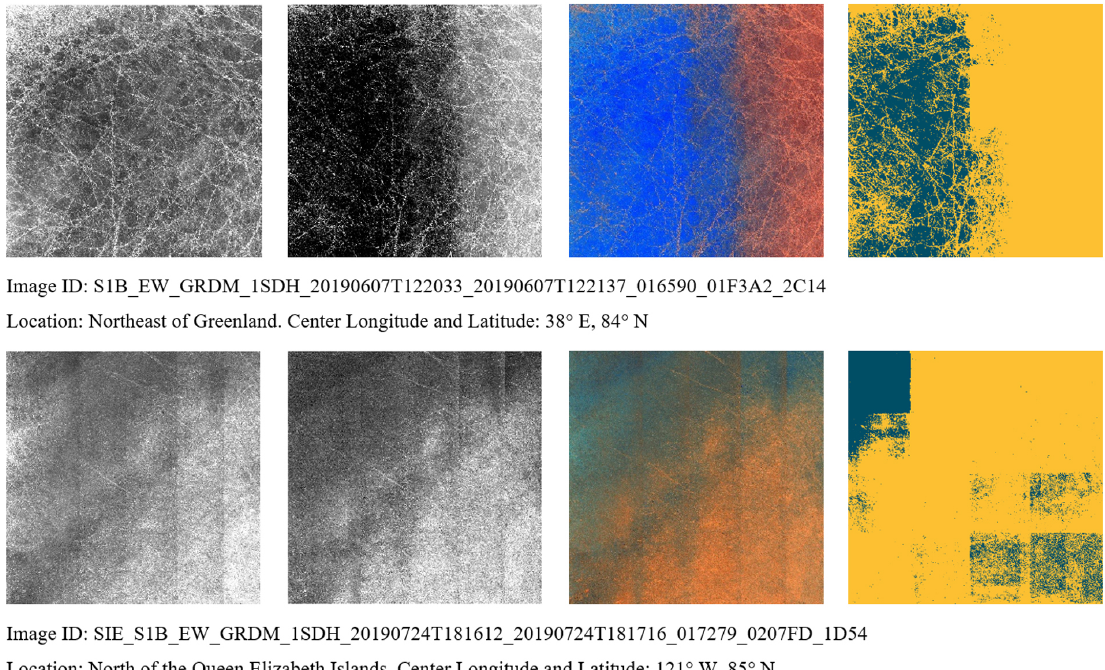
Figure 20. Examples of misclassifications that require further investigation. From left to right are S1 images in HH and HV polarization, RGB false-color composites and the S1-derived sea ice